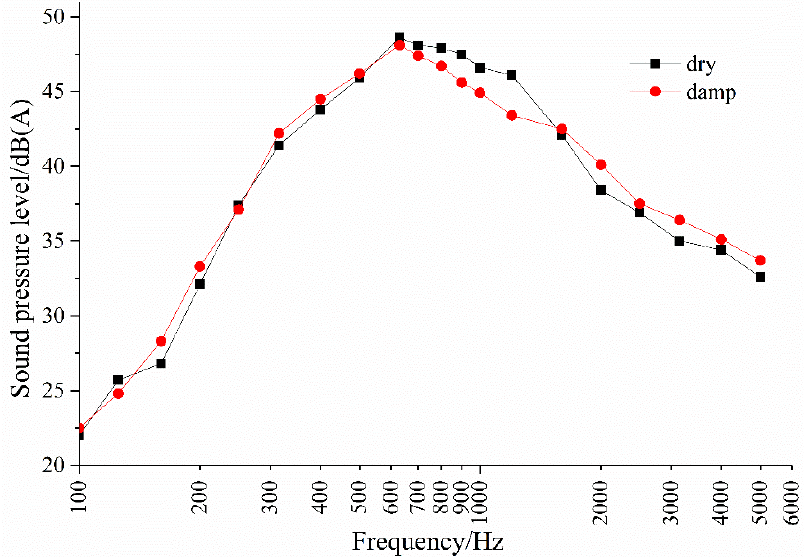
Figure 8. OGFC pavement noise spectrogram under dry or wet conditions.